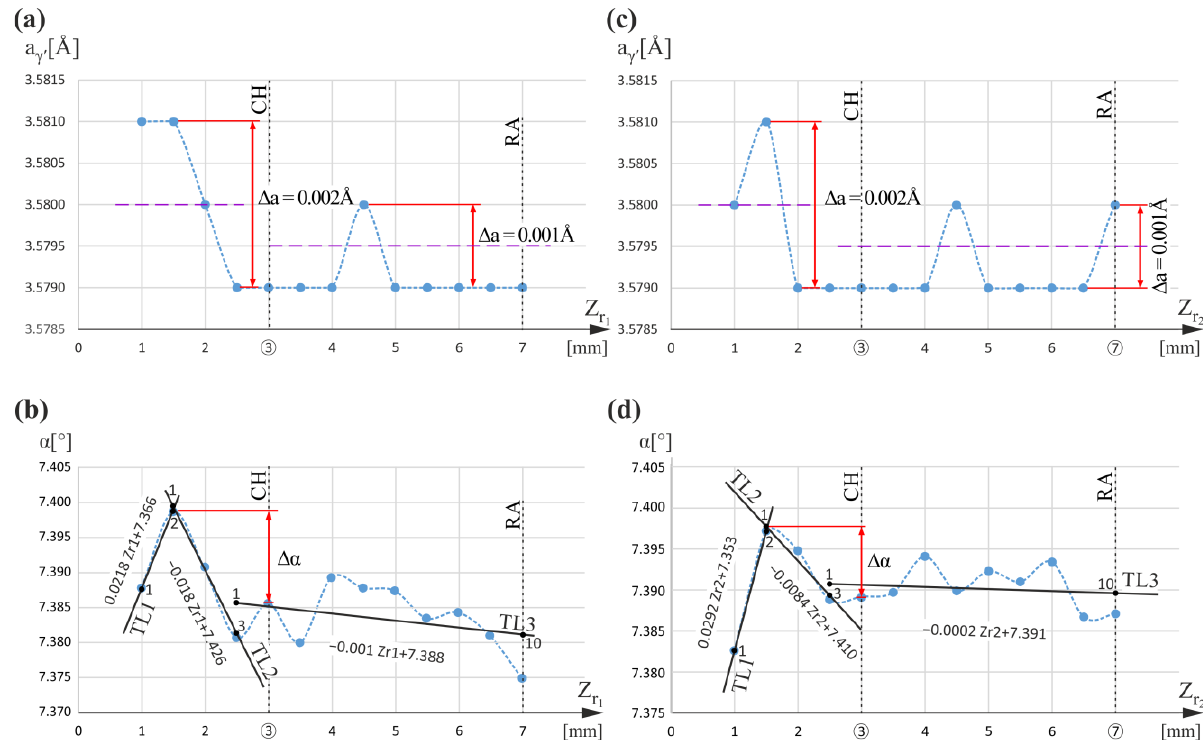
Figure 4. Graphs of the a γ′ (Z r1 ) and α(Z r1 ) relationships obtained for measurement line r 1 ( a , b ); graphs of the a γ′ (Z r2 ) and α(Z r2 ) relationships obtained for measurement line r 2 ( c , d ). Z r1 and Z r2 are parallel to Z.